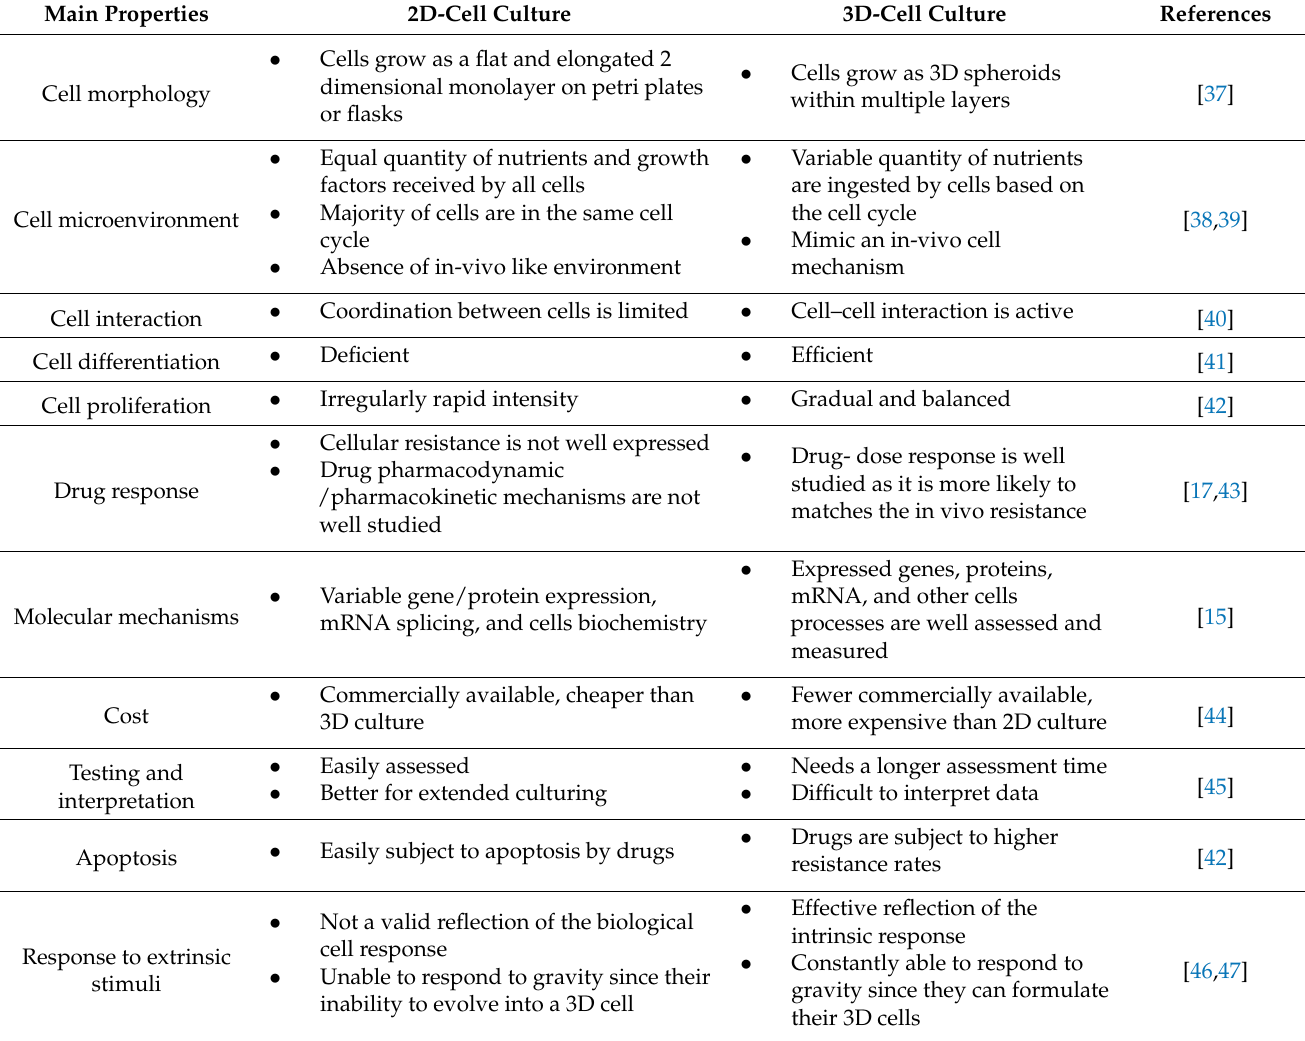
Table 1. Comparative assessment of 2D- and 3D-cell culture